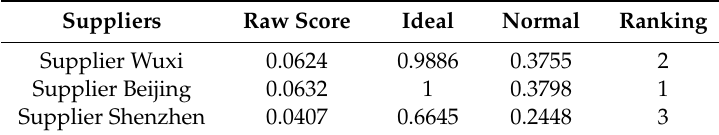
Table 4. Alternative rankings of soft competitiveness.